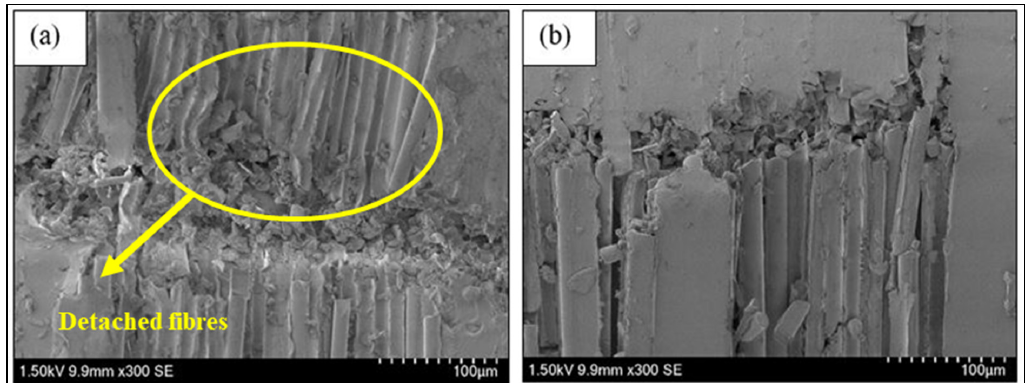
Figure 7. SEM micrographs of fractured ( a ) unmodified BFRP and ( b ) BF-H0.1 composite specimens.